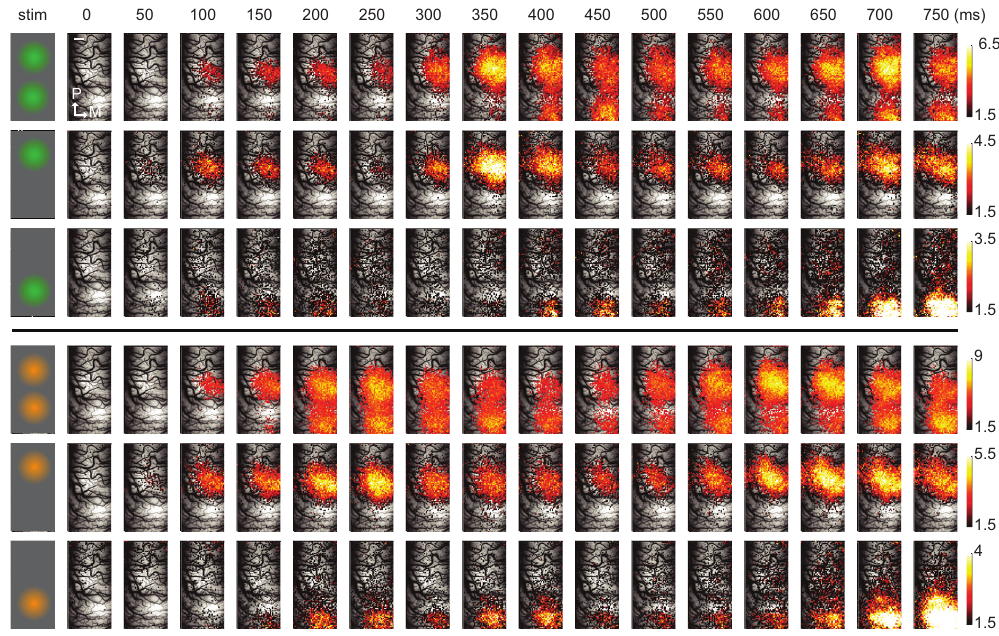
Figure 2. Dynamics of cortical activity evoked by locally presented natural stimuli. ( A ) Spatiotemporal activity patterns produced by locally presented natural movies is shown overlaid on the vascular image. Leftmost column schematically shows the corresponding stimulus condition and the movie used ( orange and green ). Each single frame represents the average activity across trials (n = 35) within 50 ms of non-overlapping segments of recorded data. The cortical representations of these stimuli were located along the antero-posterior axis, reflecting the vertical positioning of the movie-patches in the visual field. Different spatial extents and peak values of cortical activation were observed along the presentation duration at different frames. Please note that different color-scales are used for different conditions in order to emphasize the detailed spatial structure. Color scale represents Δ F/F (x10 -4 ). Color scale maximum is set to 3.3 standard deviations of activity levels. Only the most active pixels corresponding to highest 25 th percentile are shown. For a video presentation please refer to the Video S2. Scale bar (shown in the first row in the frame zero) = 1